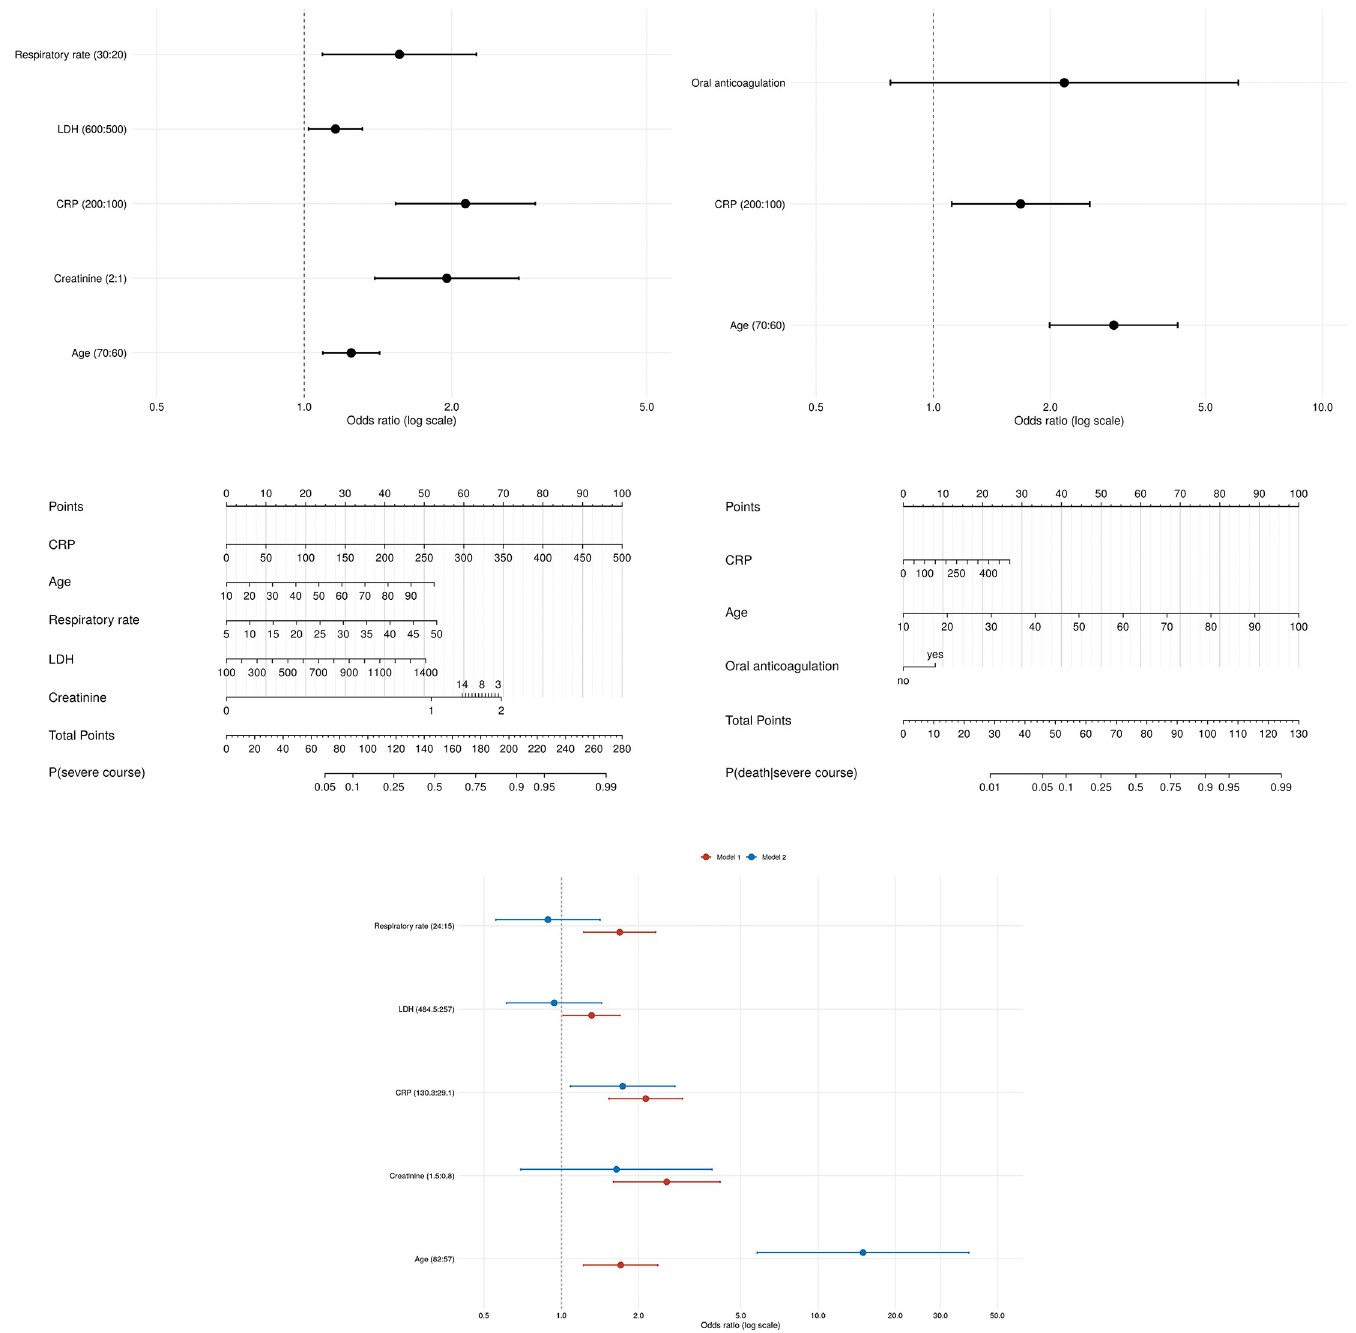
Fig 6. Predicting severity of disease from baseline data: Fig 6A (above) shows the interquartile-range odds ratios for continuous predictors (upper quartile: lower quartile) and simple odds ratios for categorical predictors (current category: reference category) with regard to a severe or fatal disease. Fig 6A (below) shows the nomogram (risk score): calculating the probability for a severe or fatal disease. For each predictor, points (0–100) are assigned. The total points are associated to event prediction. E.g. In case of an 80 years old (= 40 points) patient with CRP 150 (= 30 points), respiratory rate 24 (= 30 points), LDH 400 (= 10 points), and creatinine 2 (= 73 points), the total point score is 183 and therefore the risk for ventilation, ICU, or death is elevated with a probability of approximately 0.7. Fig 6B (above) shows the interquartile-range odds ratios for continuous predictors (upper quartile: lower quartile) and simple odds ratios for categorical predictors (current category: reference category) with regard to a fatal disease conditional of patients with at least severe diseases (mild courses are not taken into account). Fig 6B (below) shows the nomogram (risk score): calculating the probability for a fatal course of patients with severe diseases. Fig 6C This figure shows comparing effects of the above mentioned two models (model 1 for prediction of the combined endpoint versus model 2 for prediction of death in mechanical ventilated/ICU patients) by baseline parameters. The interquartile-range odds ratios for continuous predictors (upper quartile: lower quartile) and simple odds ratios for categorical predictors (current category: reference category) with regard to disease severity (Model 1) and mortality (Model 2) are